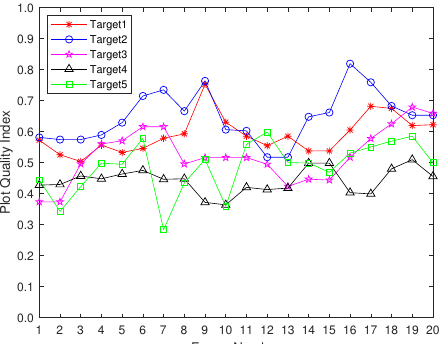
Figure 10. The variation trends of plot quality index for five moving vessels.